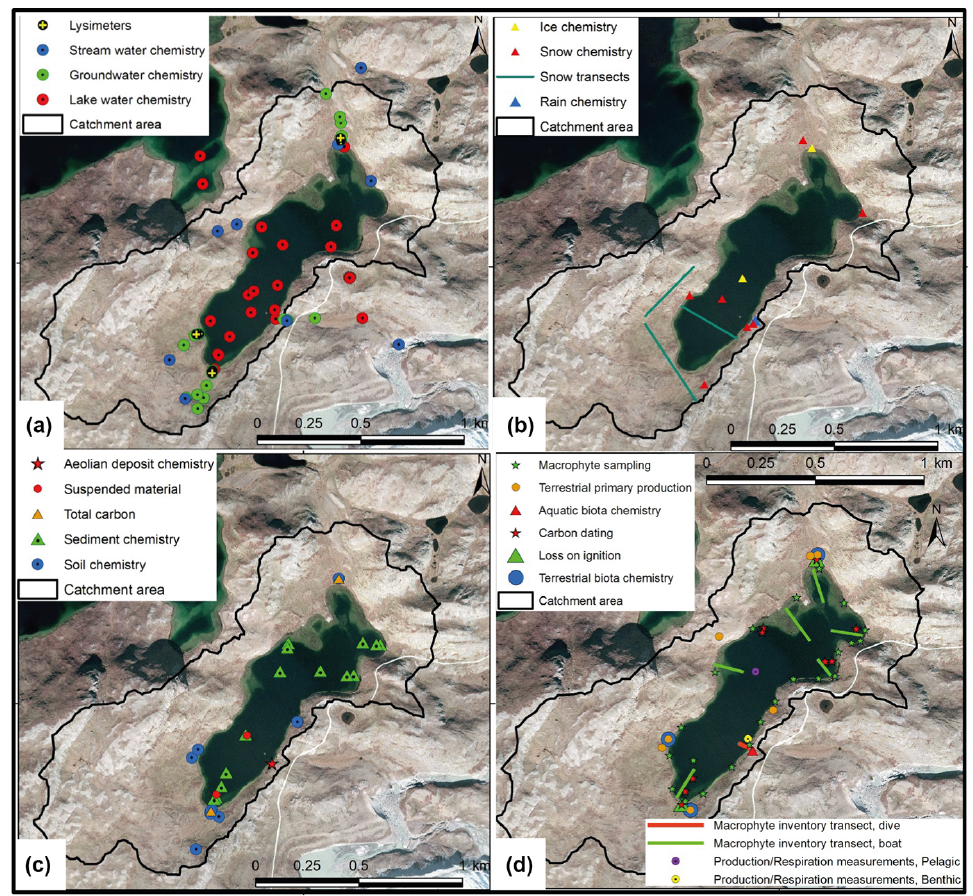
Figure 4. Maps illustrating sampling points, installations and measurement sites in the TBL catchment for groundwater and surface water (a) , ice and precipitation (b) , soils and sediment (c) and biota, carbon dating and soil loss on ignition (d) . For information on coordinates and ID for each sampling location, see PANGAEA database